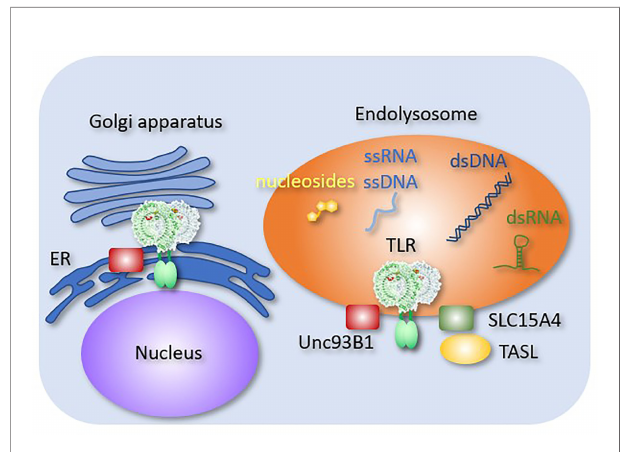
FIGURE 2 | Endosomal molecules controlling TLR responses. Endosomal molecules that control TLR responses are shown. Unc93B1 negatively regulates TLR9 dimerization. A complex consisting of SLC15A4 and TASL mediates TLR-dependent type I IFN production.